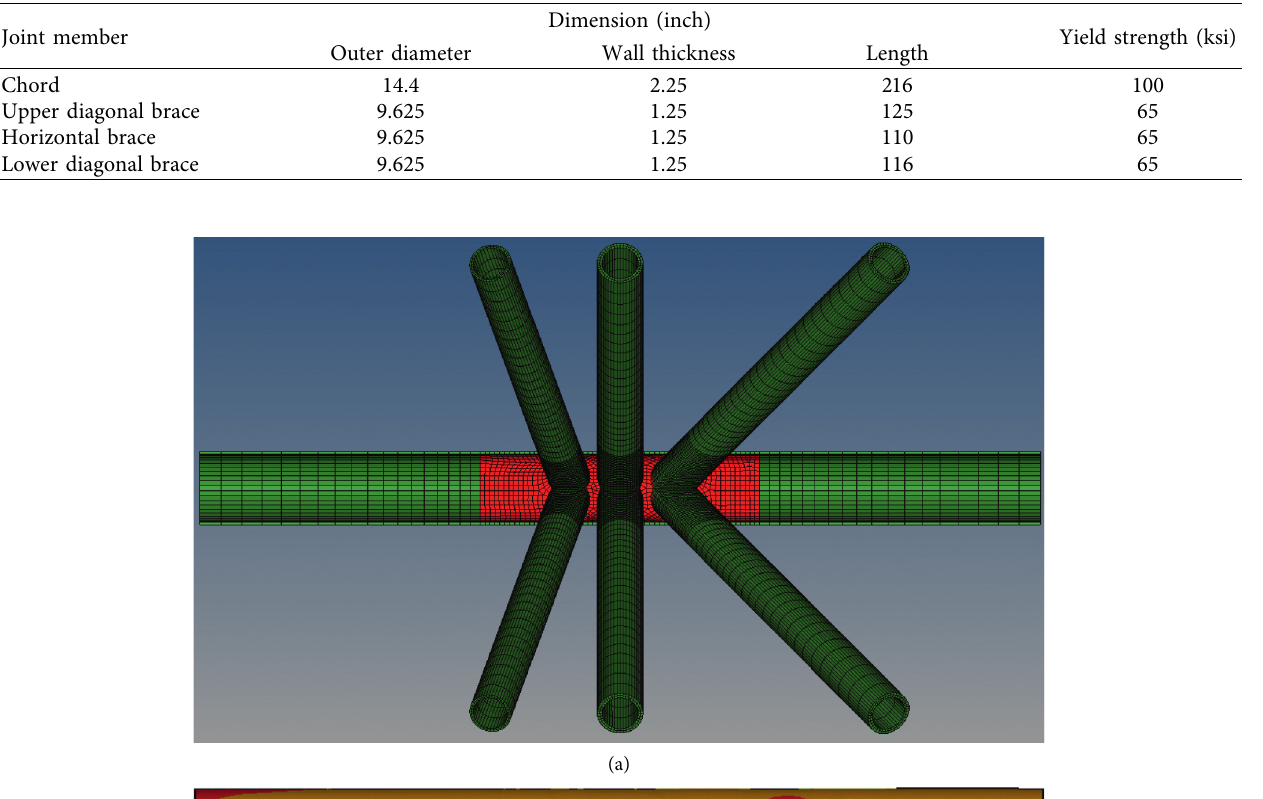
Table 1: Structural dimension and yield strength of the concerned KT-joint